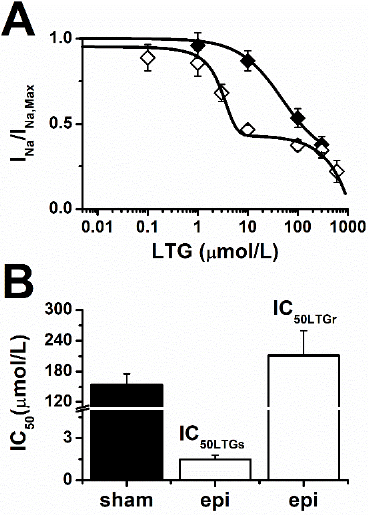
Figure 2. Epilepsy increased the affinity of LTG for I Na . ( A ) Dose response curves for sham (filled symbol) and epileptic (open symbols) animals. The curves were constructed by averaging the ratio between the I Na control value (I Na,Max ) and its amplitude at each LTG concentration tested. ( B ) IC 50 values estimated by fitting single- and dual-dose response equations (solid lines) to sham (filled) and epileptic (open) animal data, respectively. Number of cells: Sham (ctrl, LTG): 7 – 14. Epileptic (ctrl, LTG): 8 – 13. Table 2. Na + channel inactivation parameters for control conditions and during exposure to 10 µmol/L of LTG. Tukey test using one-way ANOVA (ctrl vs. LTG), * indicates p ˂ 0.05, ** p ˂ 0.01. sham V h (mV) slope ctrl